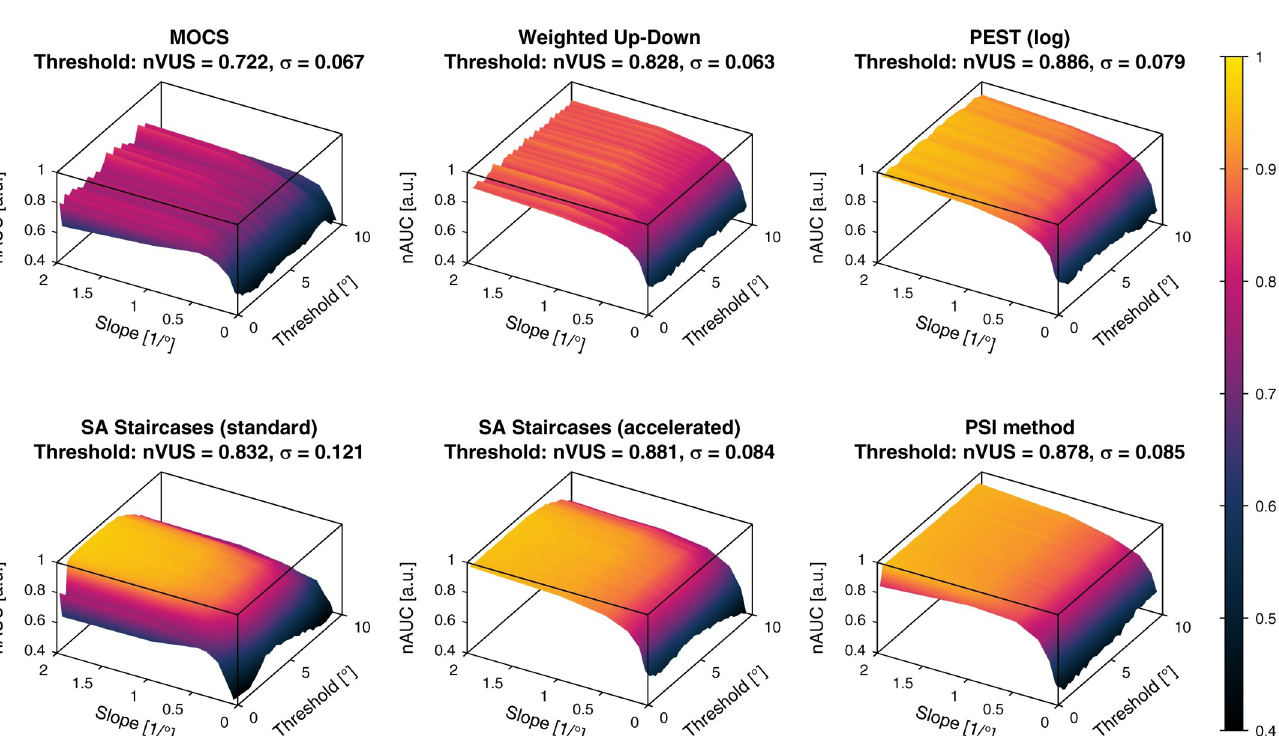
Fig 14. Normalized area under the curve for the threshold estimates. The normalized area under the curve ( nAUC , represented by surfaces for the parameter space) and corresponding normalized volume under the surface ( nVUS ) and inhomogeneity parameter σ are shown for the threshold estimation. nAUC and nVUS values of 1 correspond to a perfect threshold estimation. The color bar indicates the nAUC values in